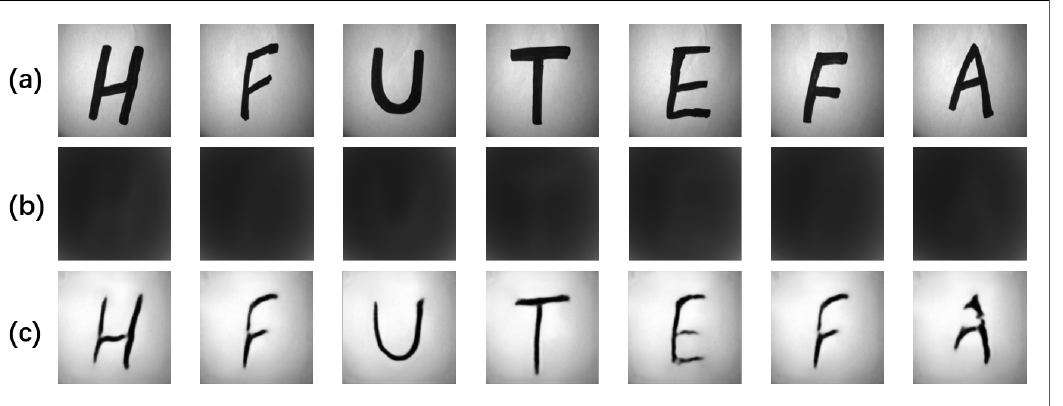
Figure 5. The reconstructed results for untrained alphabetical targets: ( a ) Ground truth; ( b ) Scattering DoP images; ( c ) Images reconstructed by the Model-DoP.